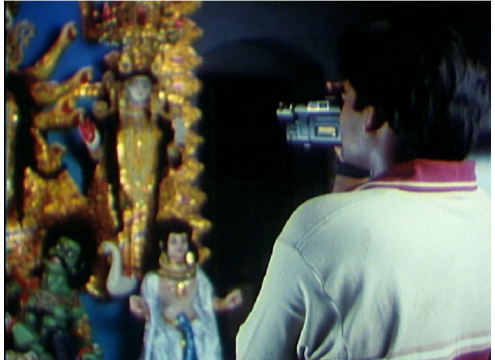
Figure 15. Joy films the pratima with his video camera, screen grab, Utsab [1].